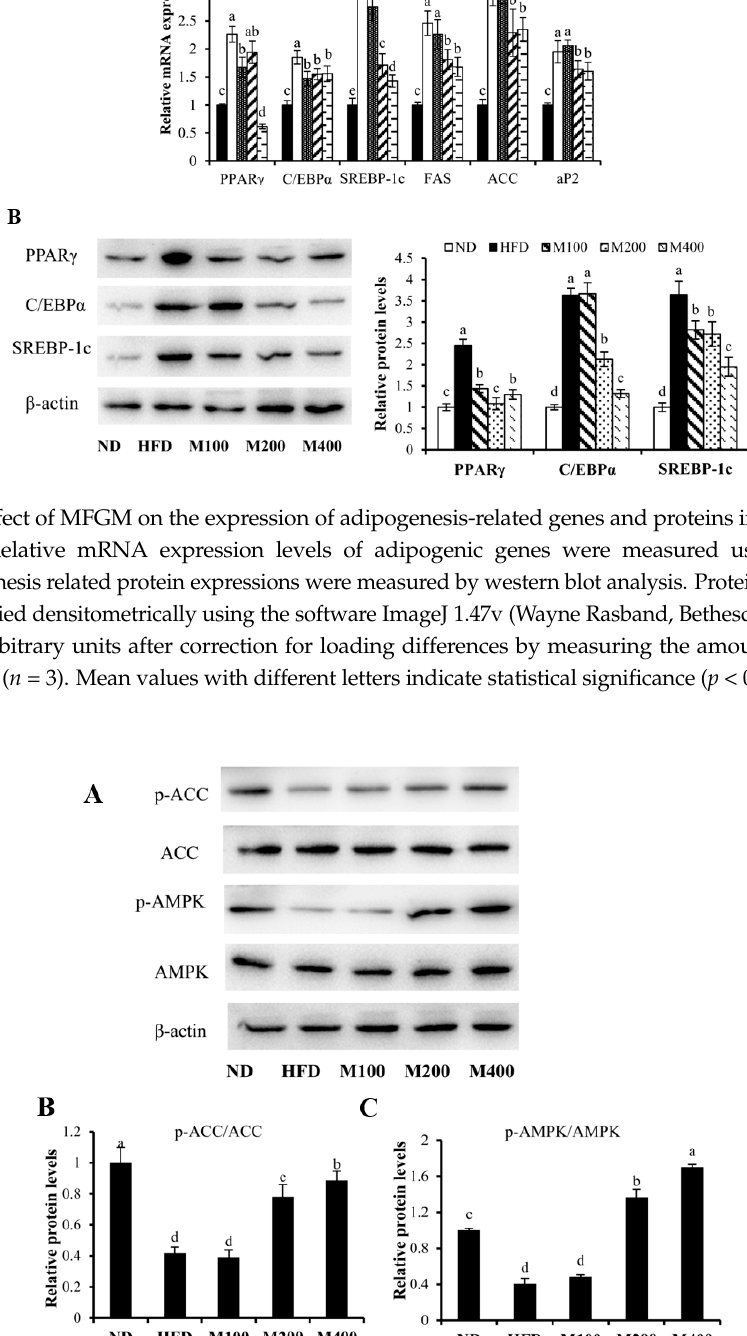
Figure 4. Effect of MFGM on the activation of AMPK pathway in epididymal WAT. The protein expressions of AMPK, p-AMPK, ACC, p-ACC ( A ) and relative protein levels of p-ACC/ACC ( B ) and p-AMPK/AMPK ( C ) were measured by western blot analysis. Protein expressions were quantified densitometrically using the software ImageJ 1.47v (Wayne Rasband, Bethesda, MD, USA), and were arbitrary units after correction for loading differences by measuring the amount of β -actin. Means ± SE ( n = 3). Mean values with di ff erent letters indicate statistical significance ( p < 0.05).